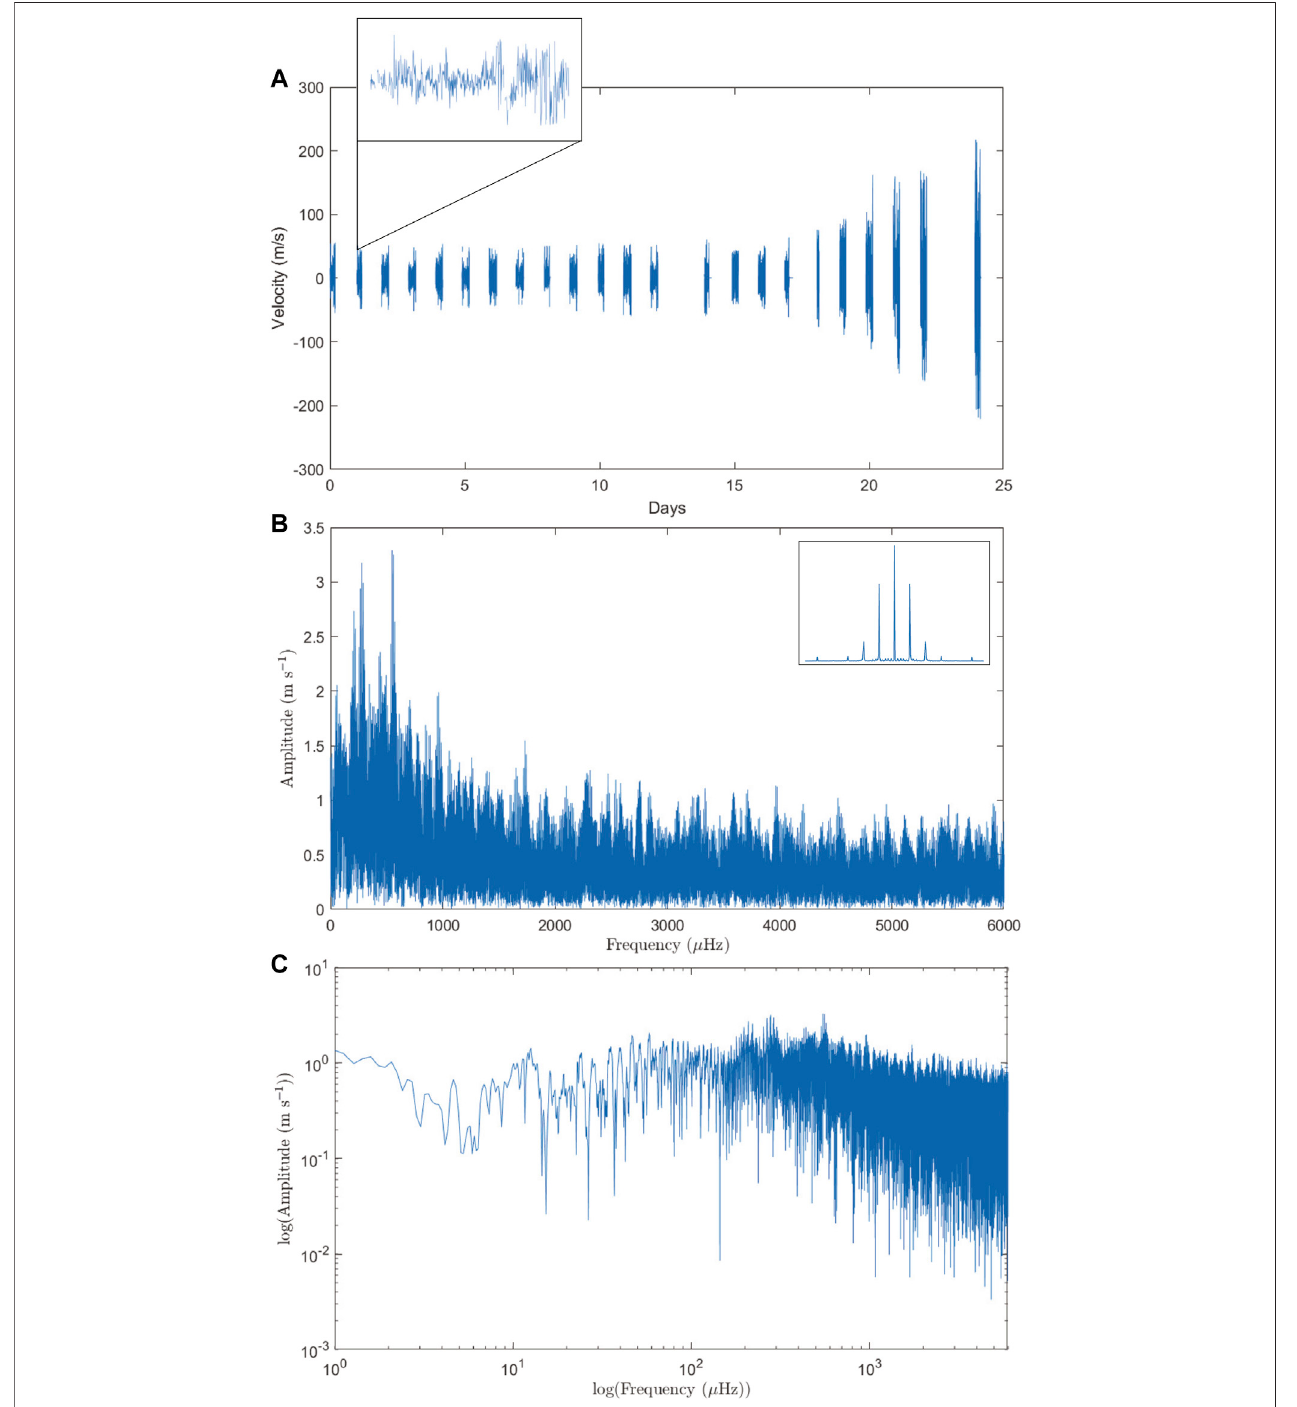
FIGURE 9 | (A) : Y m l (cid:1) ( 0 , 0 ) time series for the full 24-day observational campaign. A representative night is shown in an inset for ease of interpretation. (B) : Preliminary Y m l (cid:1) ( 0 , 0 ) calibrated amplitude spectrum for the full 24-day observational campaign. The window function is shown as an inset in the upper right-hand corner of this panel. (C) : Preliminary Y m l (cid:1) ( 0 , 0 ) amplitude spectrum, as in Panel (B) , in a log-log